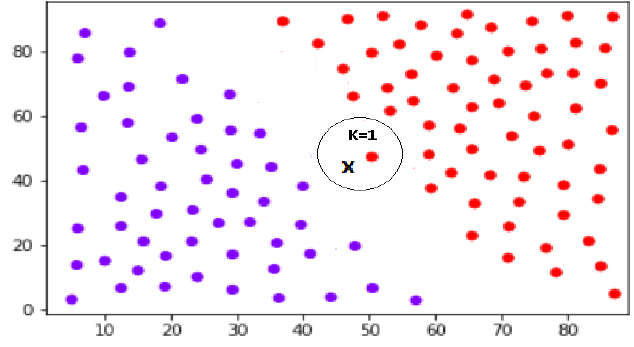
Figure 2. KNN classifier with diabetes data